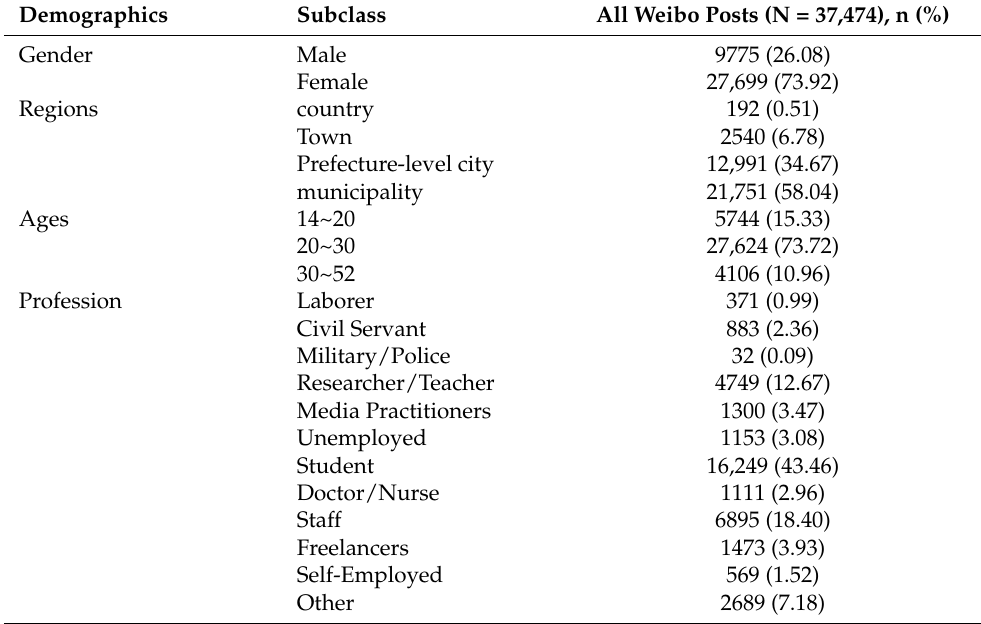
Table 2. Demographics of participants.